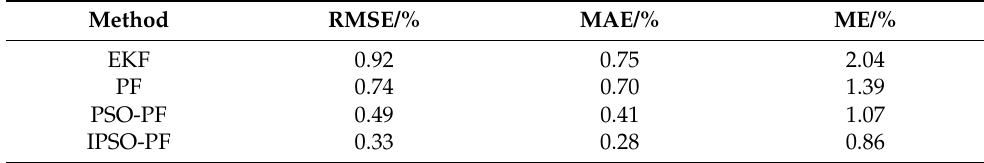
Table 7. Errors of BJDST Driving